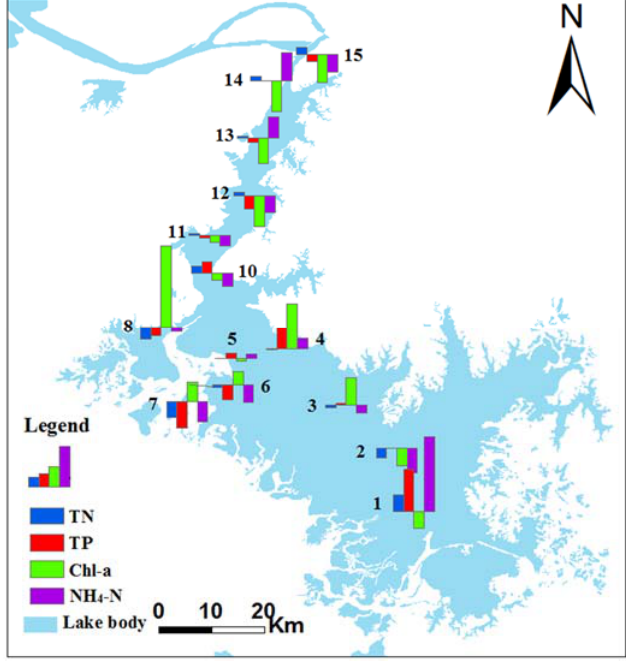
Figure 5. Ratios of the average TN, TP, Chl–a, and NH 4 –N values for each site relative to the all-site average between 2009 and 2014.